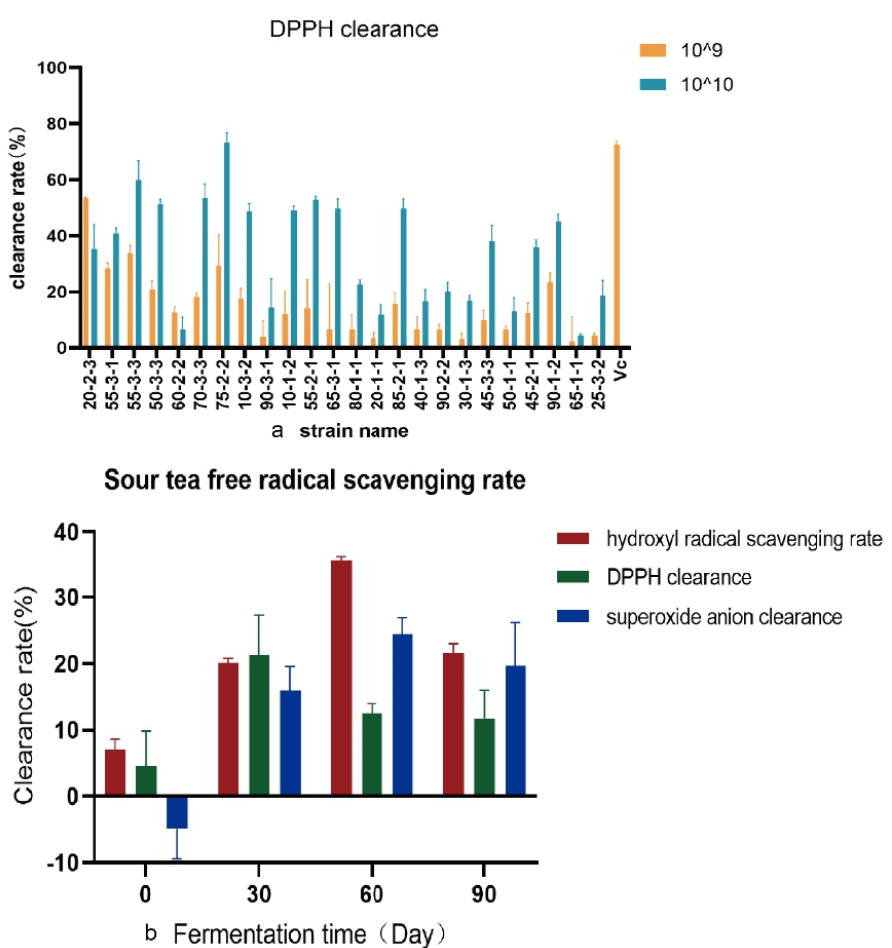
Figure 3. Antioxidant capacity was measured ( a ) DPPH free radical scavenging rate of 24 strains of Lb. plantarum isolated from sour tea. Vc (0.8 mg/mL) was the positive control. Orange represents the bacterial concentration of 10 9 CFU, and blue represents the bacterial concentration of 10 10 CFU. ( b ) Free radical scavenging rate of sour tea fermented at different